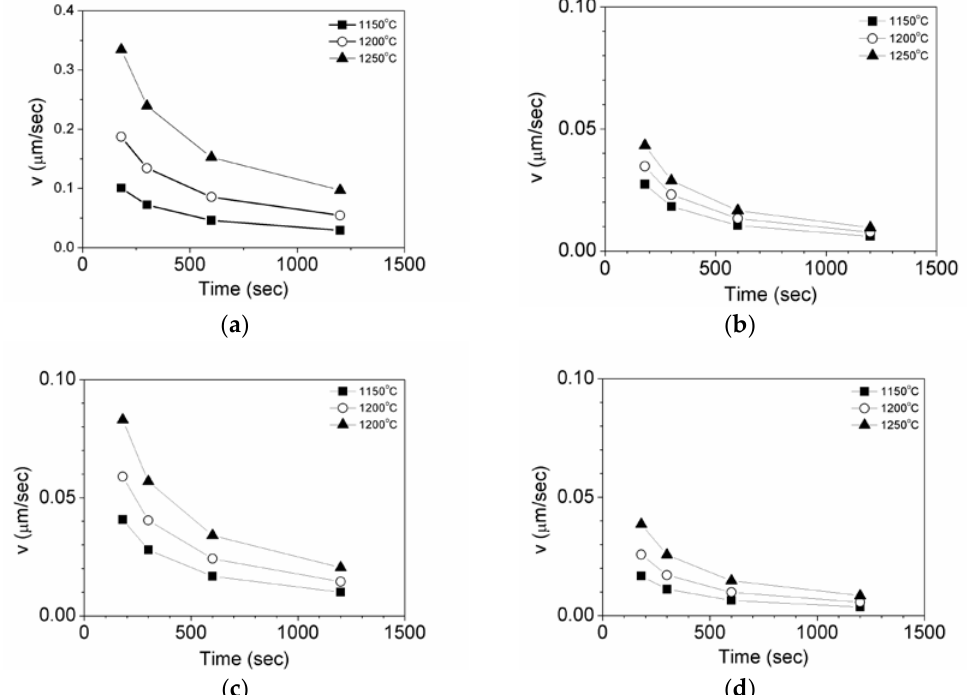
Figure 7. The grain boundary velocity ( V ) as a function of time for Mg at ( a ) 1.5, ( b ) 5.6, ( c ) 11, and ( d ) 22 ppm.